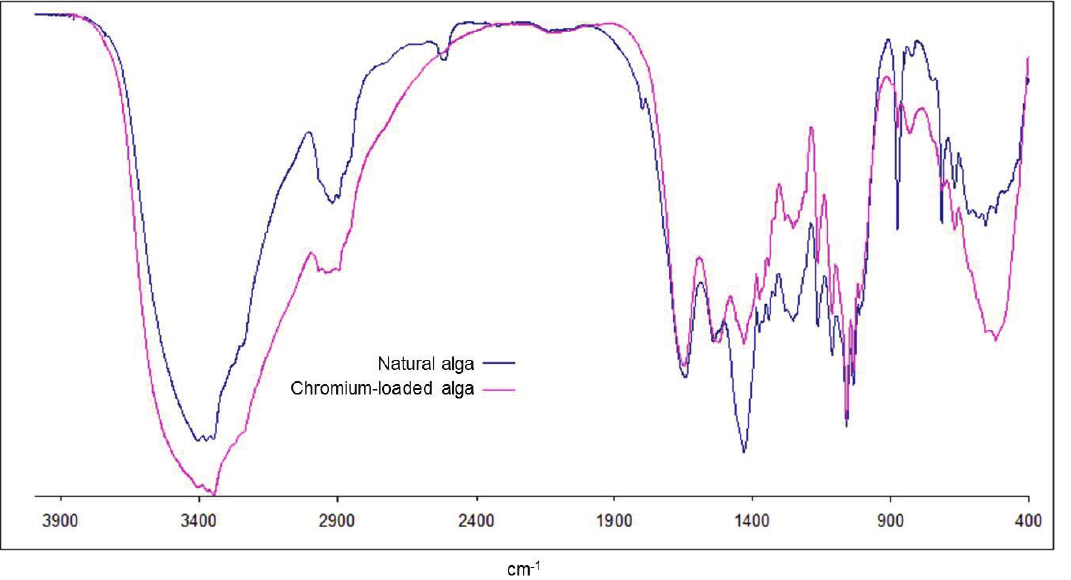
Figure 7: FTIR spectra for the natural and chromium-loaded Cladophora